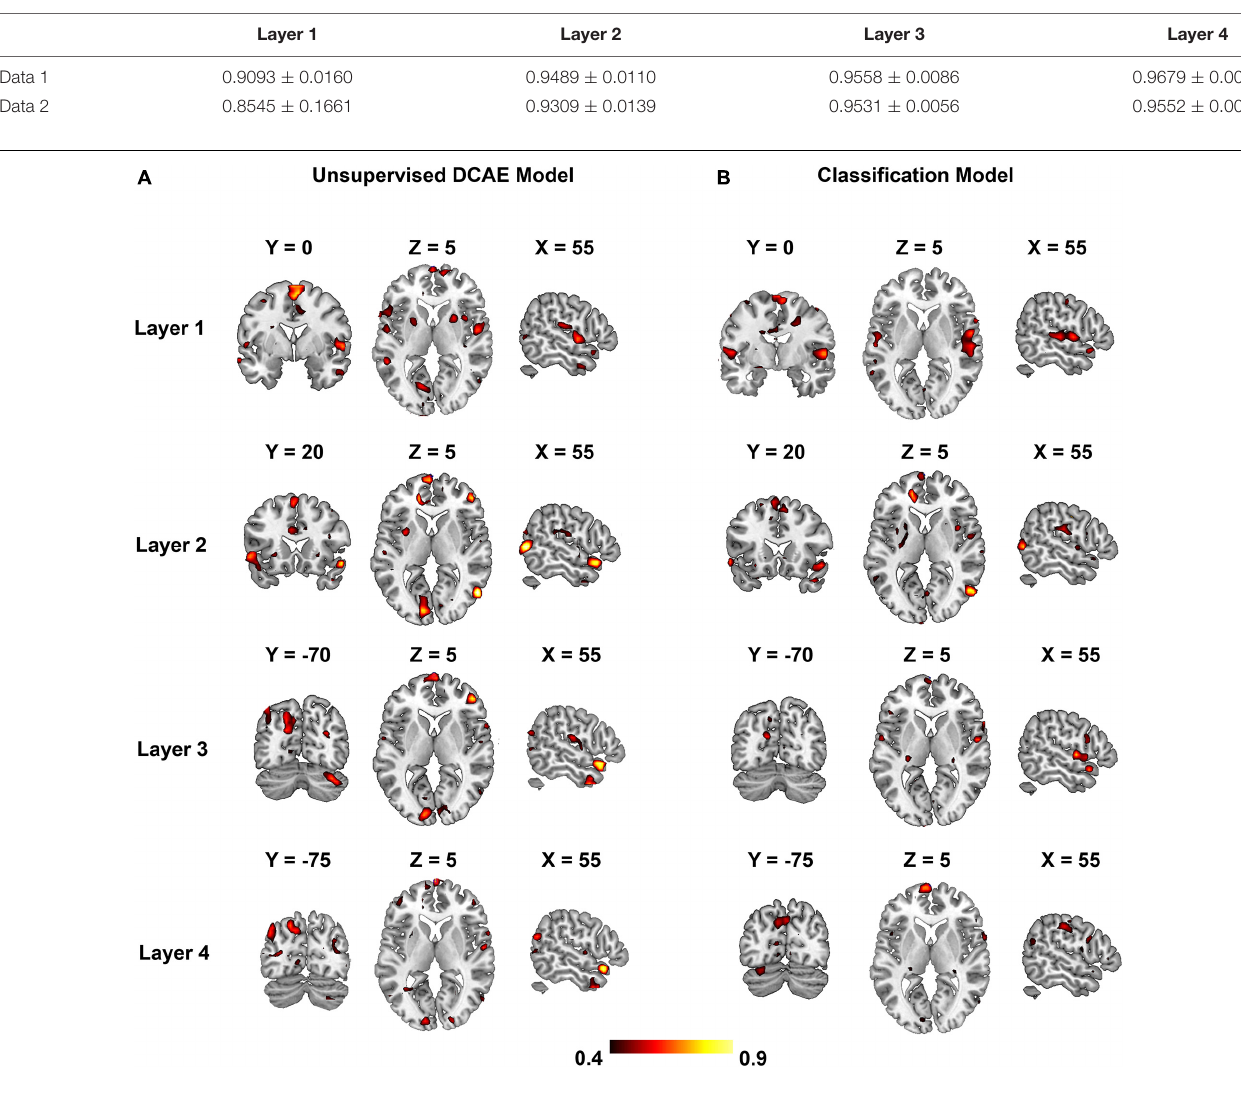
TABLE 3 | The classification accuracies in different layers of the supervised model.